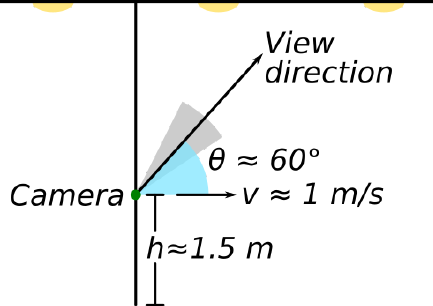
Figure 5. Measurement parameters used in the experiments. The acquisition process with the Lenovo Phab 2 Pro was done at a normal walking speed of around 1 m/s, at 1.5 m from the floor with a pitch of approximately 60 ◦ .